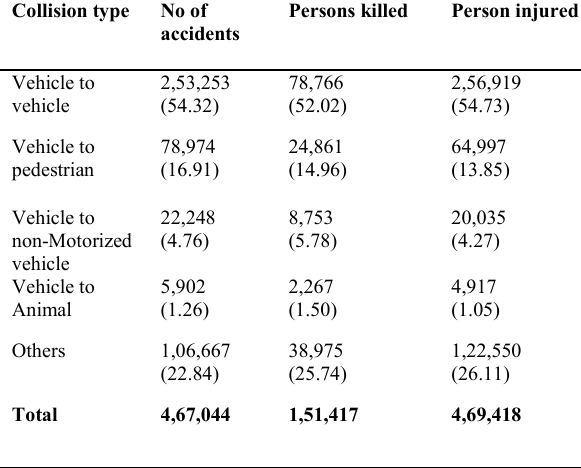
Table 2. Road Accidents, Fatalities and Injuries